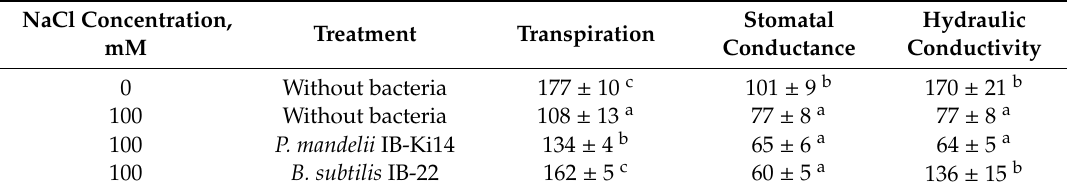
Table 4. E ff ects of 100 mM NaCl and rhizosphere inoculation with P. mandelii IB-Ki14 and B. subtilis